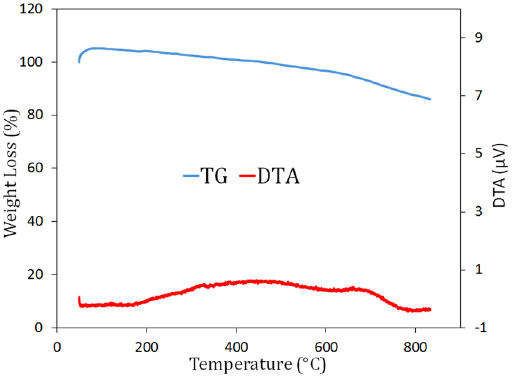
Figure 10. TG and DTA diagrams of the prepared sample M23 after combustion and the leaching treatment.